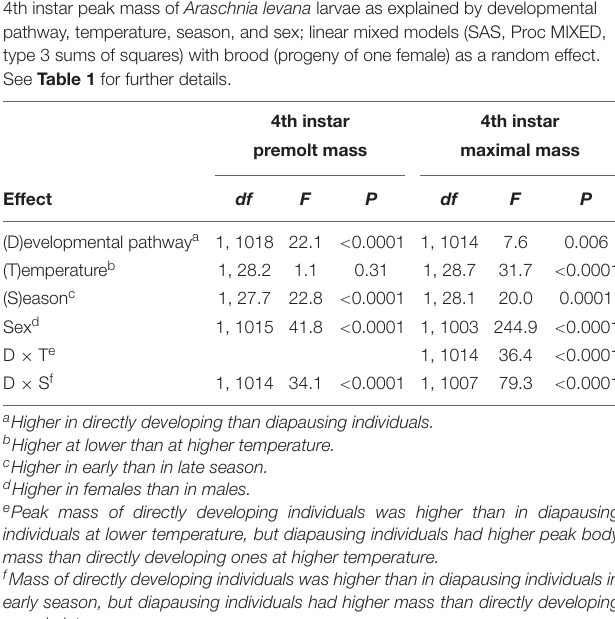
TABLE 5 | Pupal mass of Araschnia levana as explained by developmental pathway, temperature, season, and sex; linear mixed models (SAS, Proc MIXED, type 3 sums of squares) with brood (progeny of one female) as a random